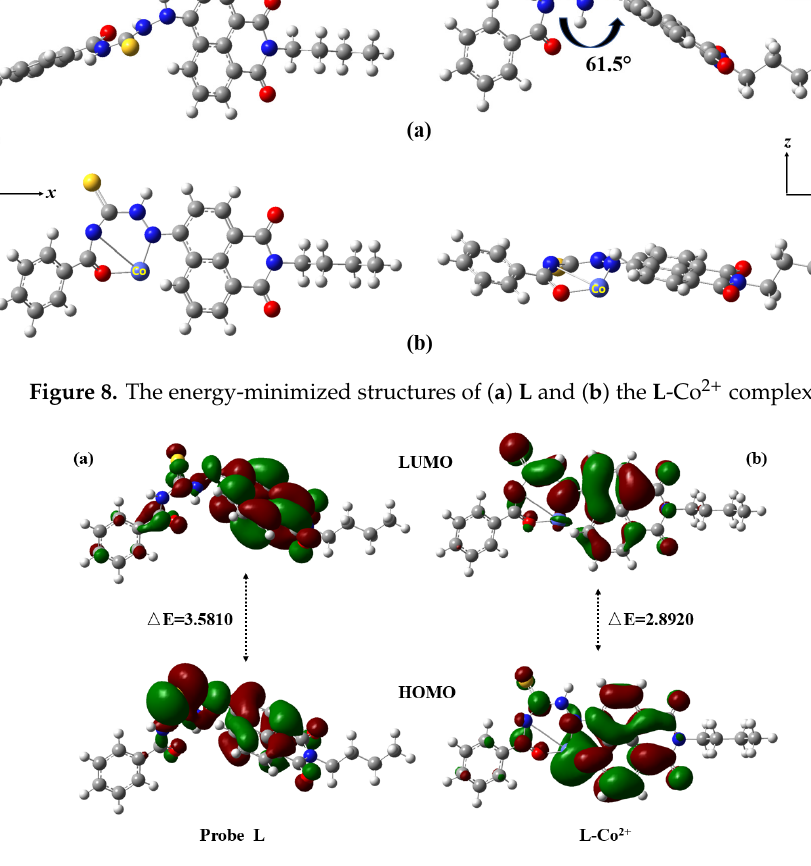
+ . Molecules 2019 , 24 , x FOR PEER REVIEW